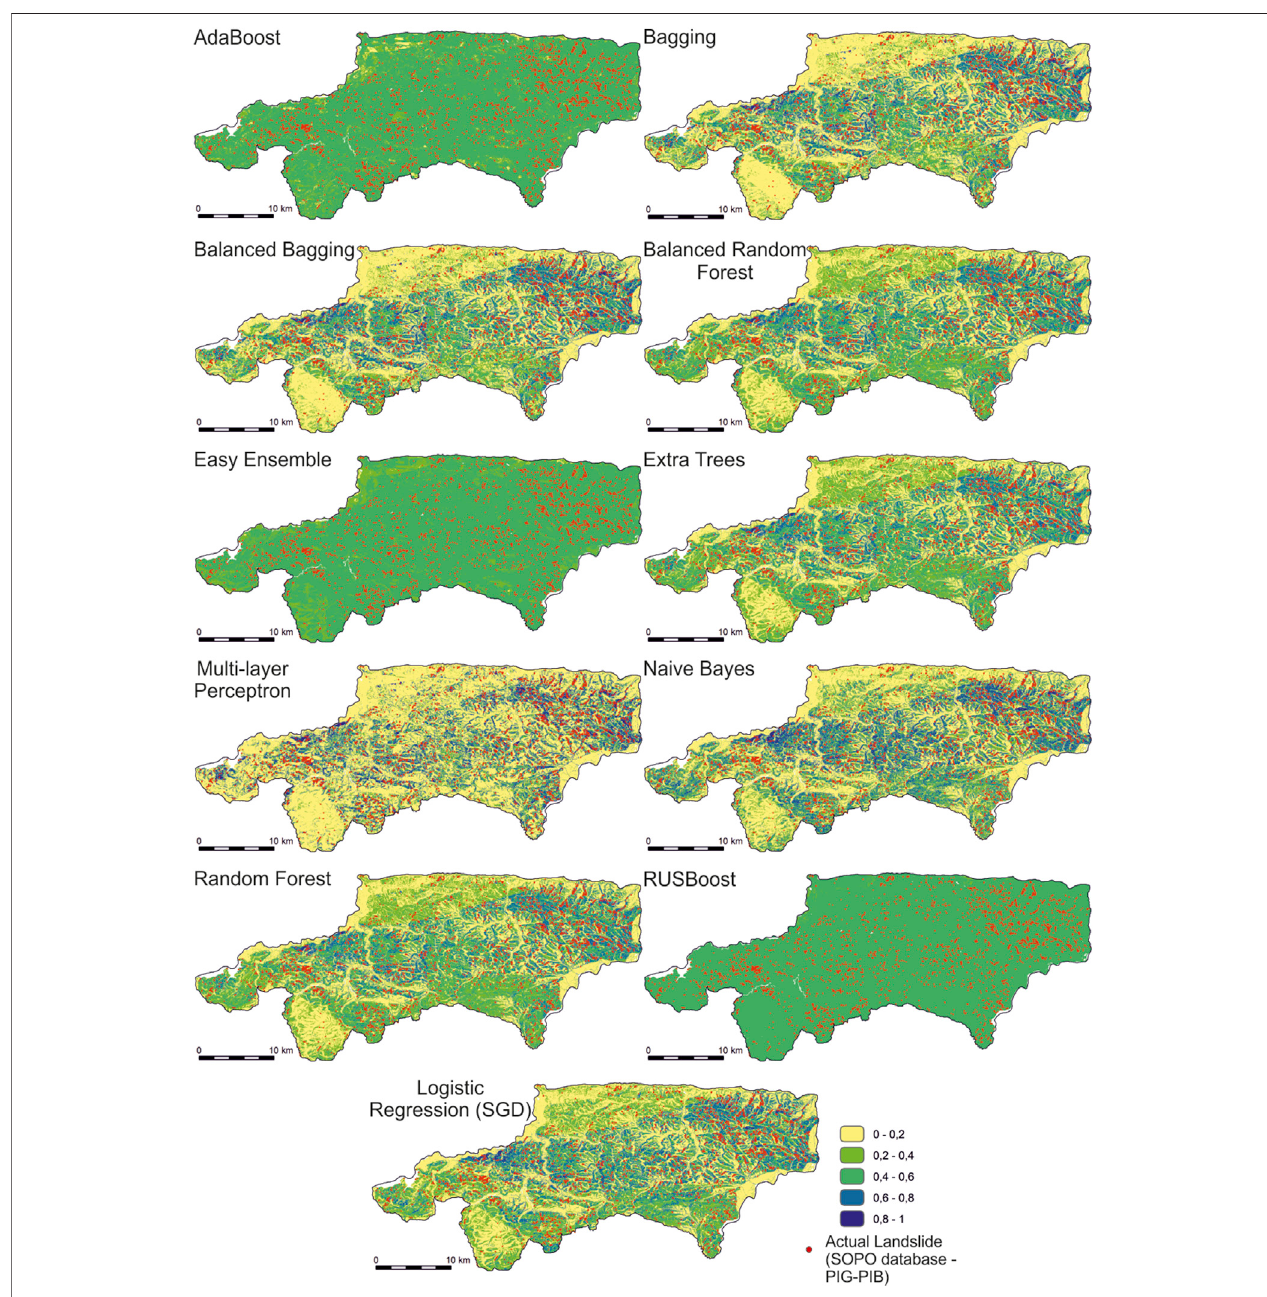
FIGURE 8 | Probability distribution maps of shallow mass movements for the algorithms